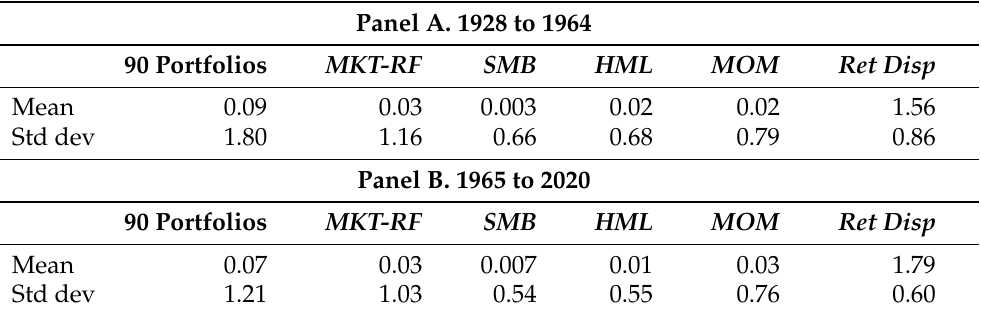
Table 1. Descriptive statistics for U.S. stock returns in the sample period of January 1928 to